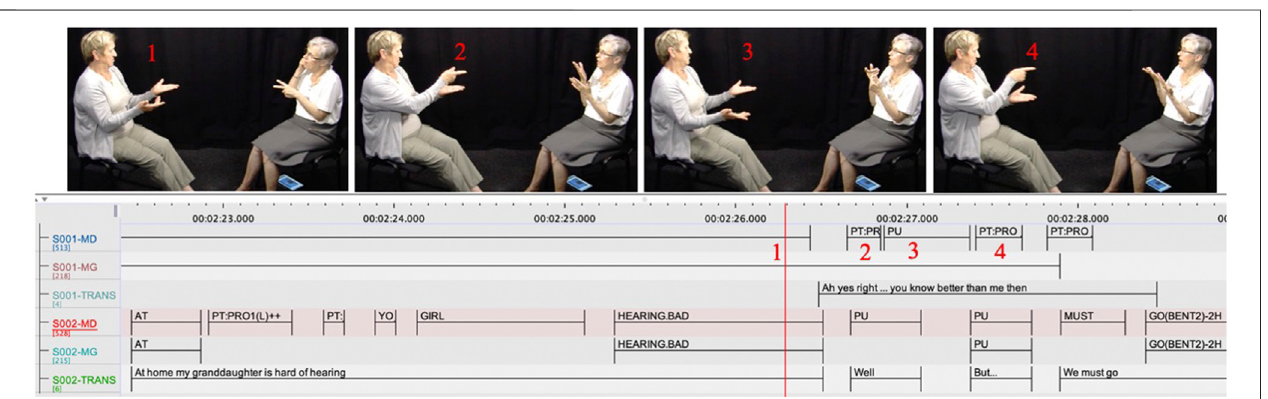
FIGURE 3 | Repeated backchanneling pointing by S001 (LSFB Corpus, 02:22.463-02:28.469).